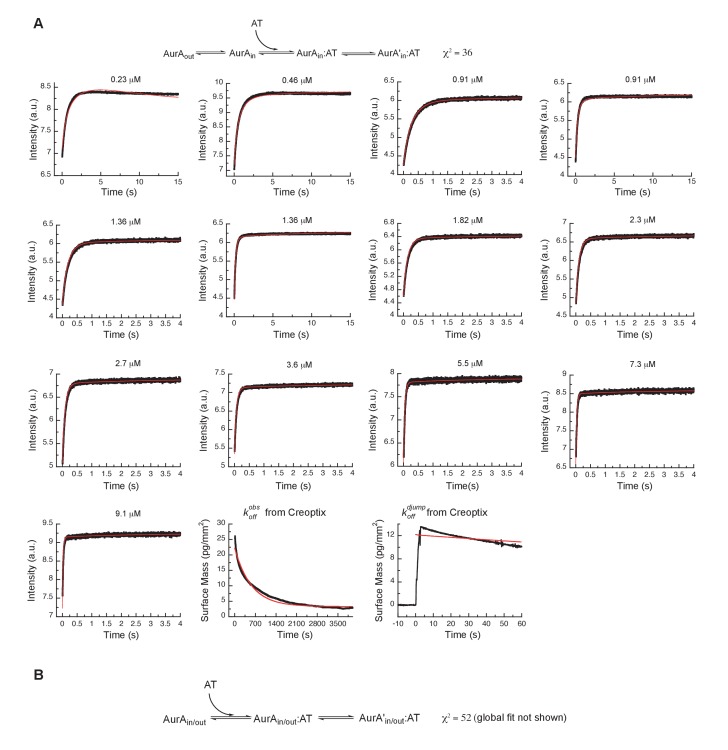
Alternative binding models of AT9283 to Aurora A cannot explain the experimental data.(A) Our initial three-state binding scheme, where AT9283 binds only the DFGin state of Aurora A and is followed by an induced-fit step, is incorrect. The best global fit (shown in red) did not describe the data as can be seen by visual inspection and from the reduced χ2 value of 36. (B) An alternative model, where AT9283 can bind to Aurora A irrespective of the state of the DFG-loop, and binding is followed by an induced-fit step did not result in adequate fits (data not shown) and yield a reduced χ2 value of 52. In both cases the values for the interconversion between AurAout and AurAin were taken from the Gleevec experiment (Figure 5—figure supplement 2). Fluorescence traces are the average of at least five replicate measurements (n > 5).